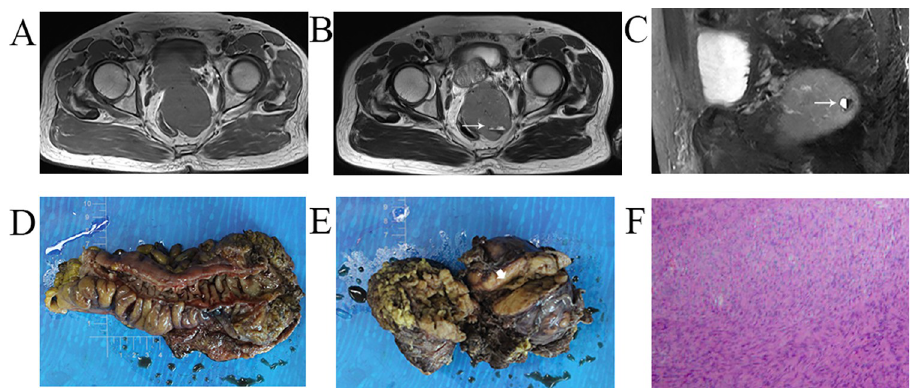
Fig 1. Representative images of computed tomography scans and histological examinations of patients with an air-fluid level. T1WI, T2WI, and Fat-suppression sequence showed (A) the mass and (B, C) air-fluid level (white arrow);.The tumor was extramural to (D) the colon wall and (E) the cavity (white arrowhead), which can be observed in the specimen; (F) Histopathological result of H&E staining showing the spindle cells (magnification,